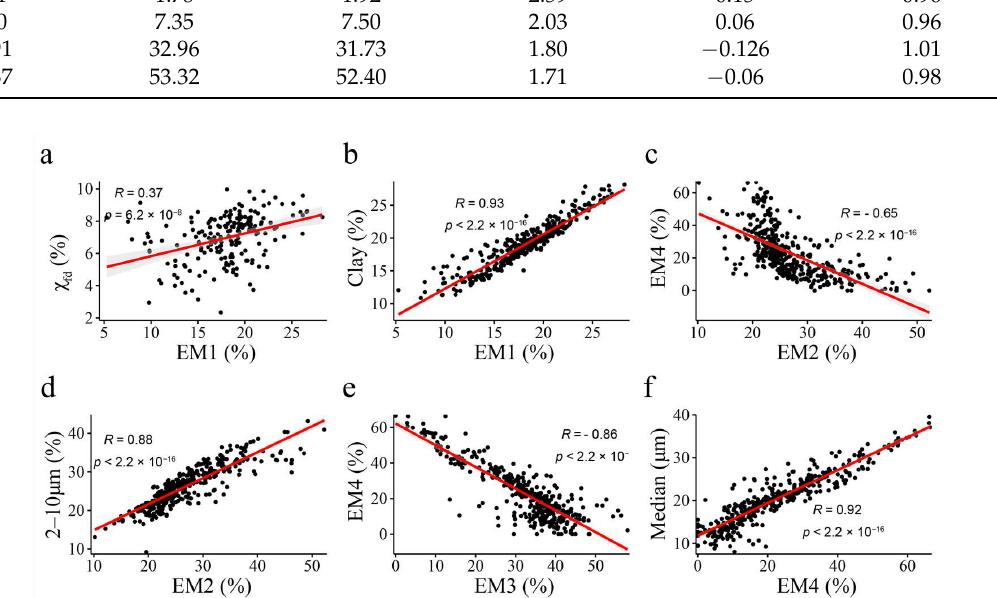
Figure 4. The correlations between ( a ) EM1 and χ fd %, ( b ) EM1 and clay, ( c ) EM2 and EM4, ( d )